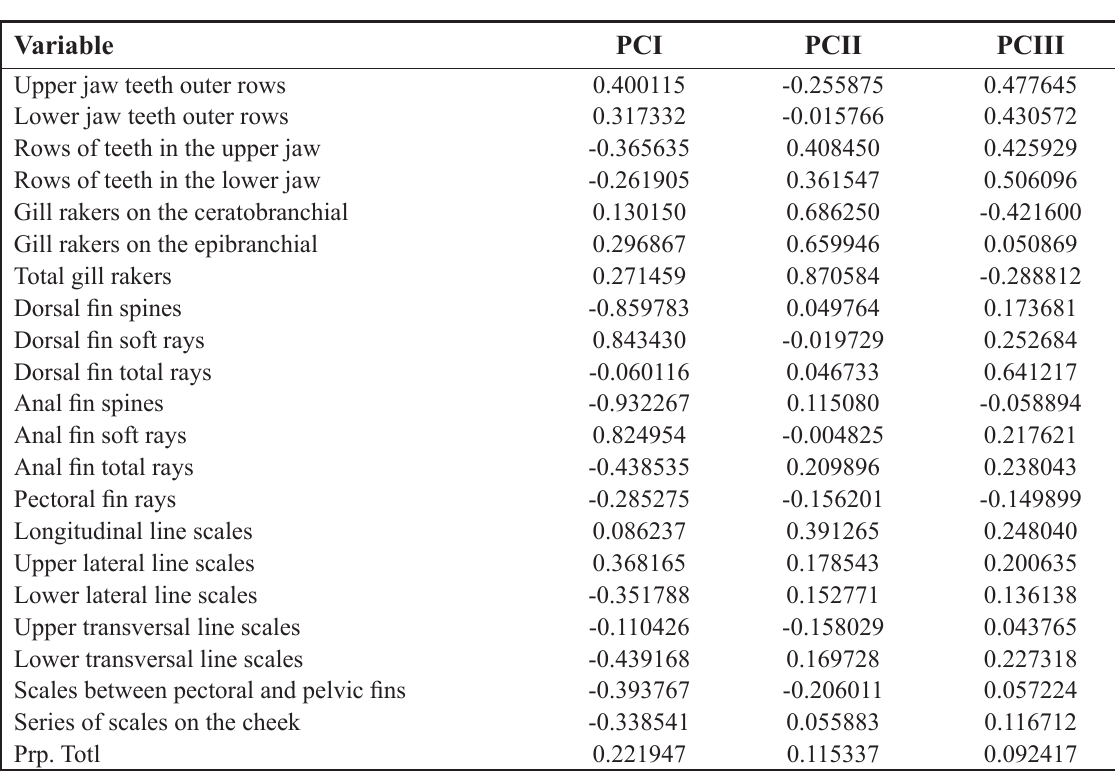
Table 1. Principal component loadings of the meristics on the first three axes of all Astatoreochromis specimens